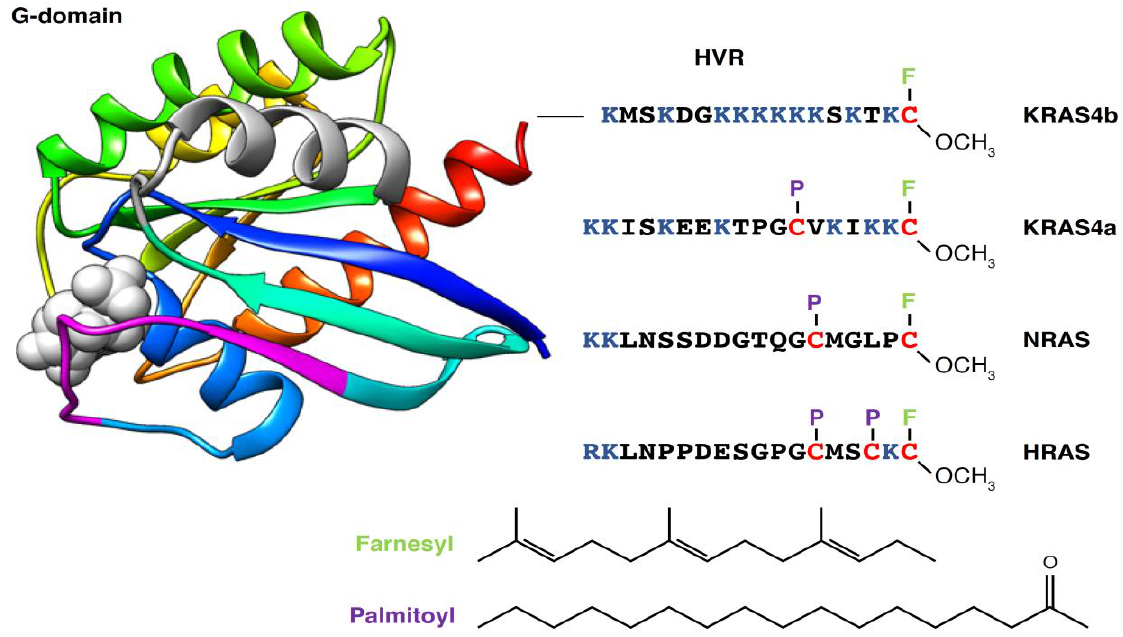
Figure 2. Comparison of RAS isoform hypervariable region (HVR) sequence and lipid modification. The RAS G-domain (PDB 4OBE) is 90% identical across isoforms. RAS is shown using a ribbon representation colored by sequence, for example: α 1 (blue), switch 1 (30–38, magenta), switch 2 (60–76, gray), α 3 (green), α 4 (yellow) and α 5 (red). F represents a farnesyl group, and P represents a palmitoyl group.